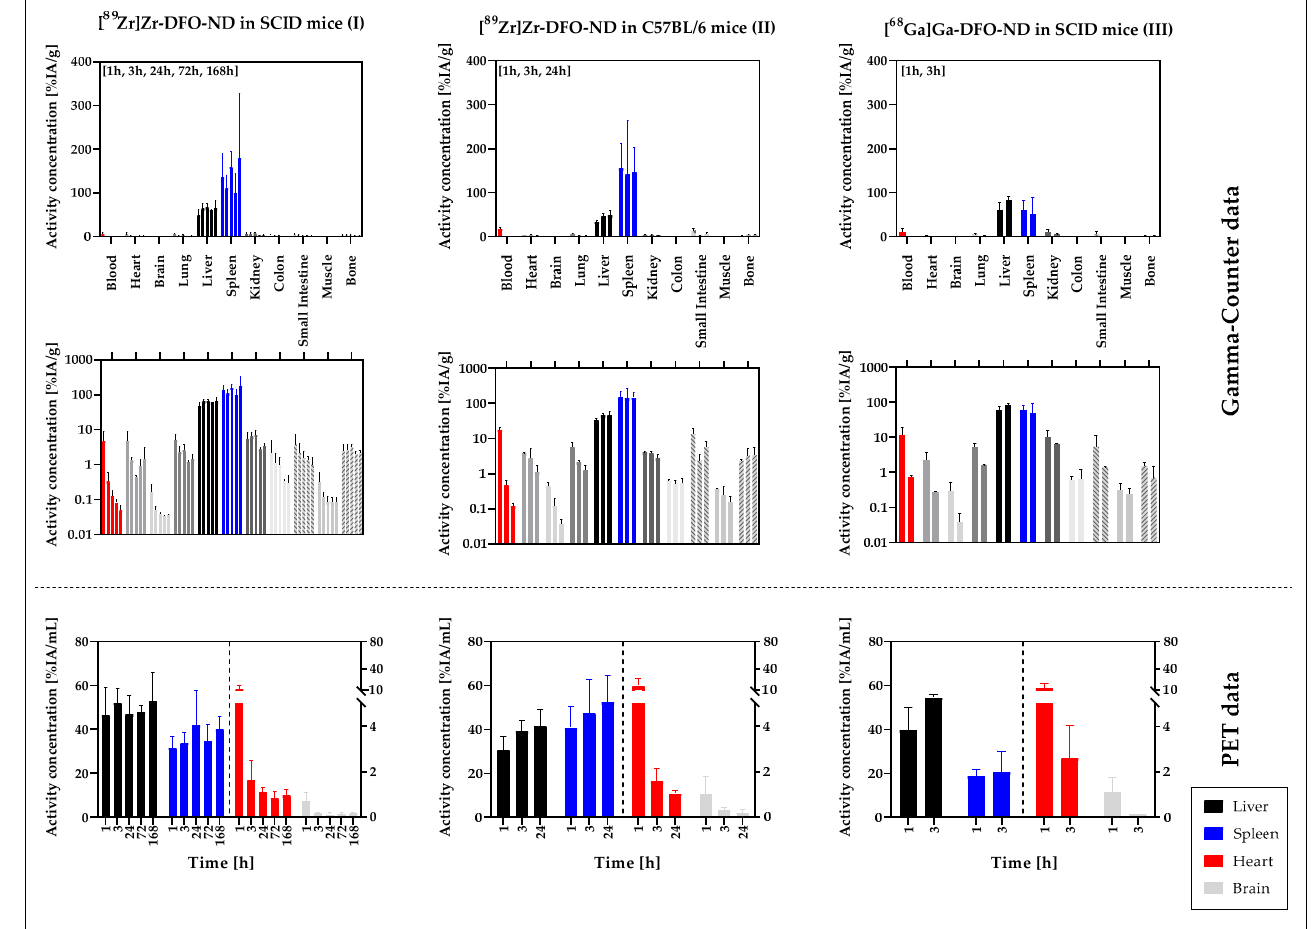
Figure 5. Mean and SD of weight-normalized organ accumulation [%IA/g] of radiolabeled NDs in the respective mouse model based on gamma counter evaluation and compared with the PET-based evaluation. The gamma counter-based evaluation is presented in the top row (linear scale) and middle row (logarithmic scale), whereas the PET-based data are presented in the bottom row (linear scale). For PET data, liver and spleen values are associated with the left ordinate, while heart and brain values are associated with the right ordinate. Liver, heart (blood, in case of gamma counter data), and spleen as the main organs of activity distribution are highlighted in color.